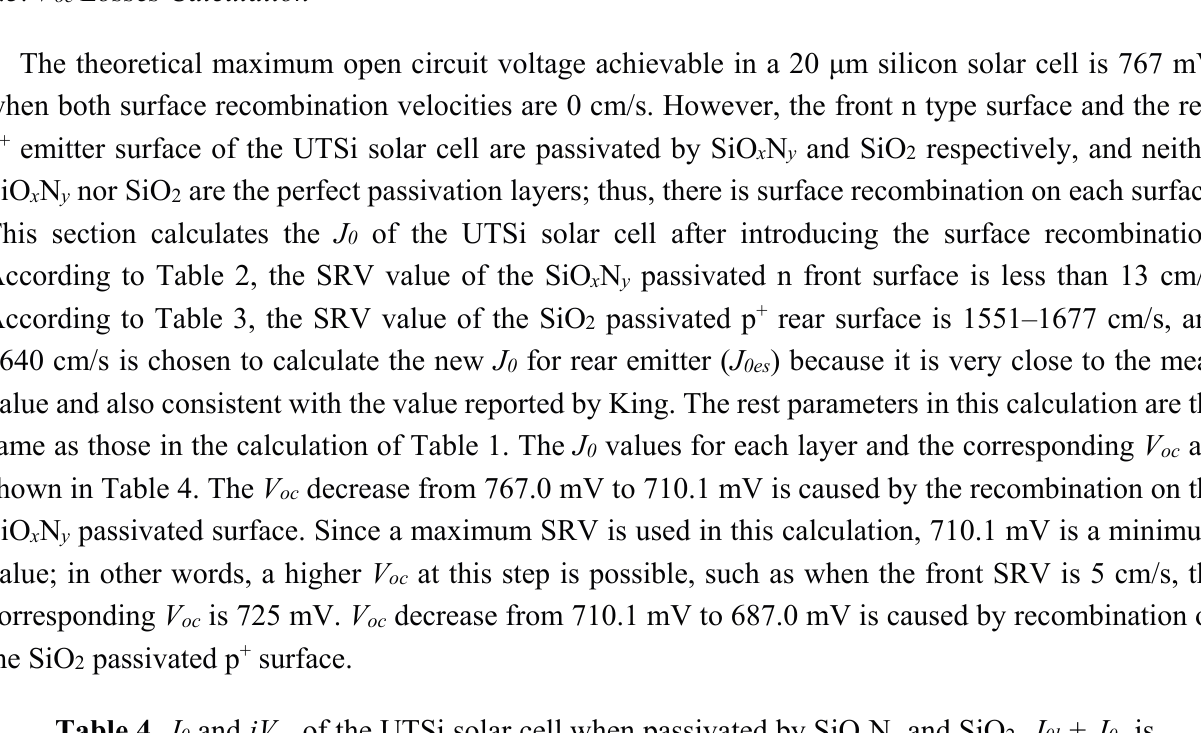
Table 4. J 0 and iV oc of the UTSi solar cell when passivated by SiO x N y and SiO 2 . J 0b + J 0e is from Table 1, and J 0bs is the reverse saturation current density of the base and J 0es is the reverse saturation current density of the emitter when taking SRV into